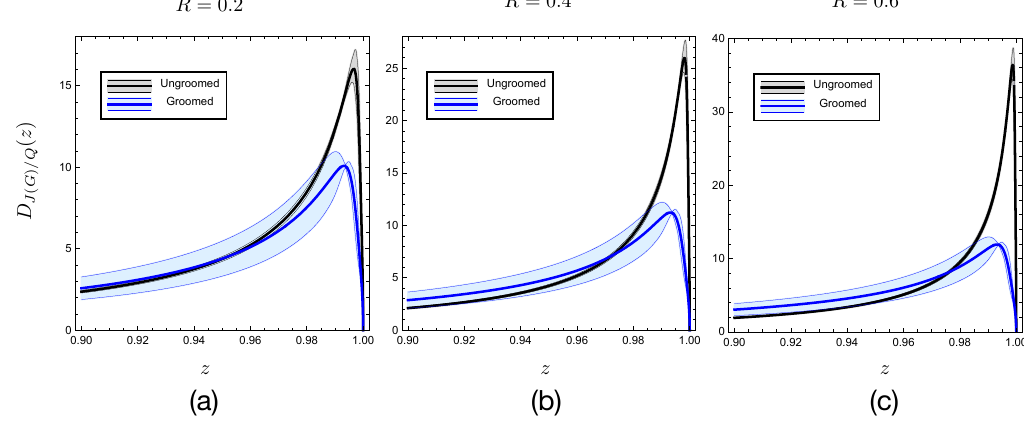
Figure 9 . FFJ and FFGJ for top quark jets near threshold, with a hierarchy between jet scale (size) and heavy quark mass, i.e., E J R (cid:29) m t . In this figure, E J = 2 TeV and z cut = 0 . 1 . Panels (a), (b), and (c) show different choices of the jet radius R = 0 . 2 , 0 . 4 , and 0 . 6 ,